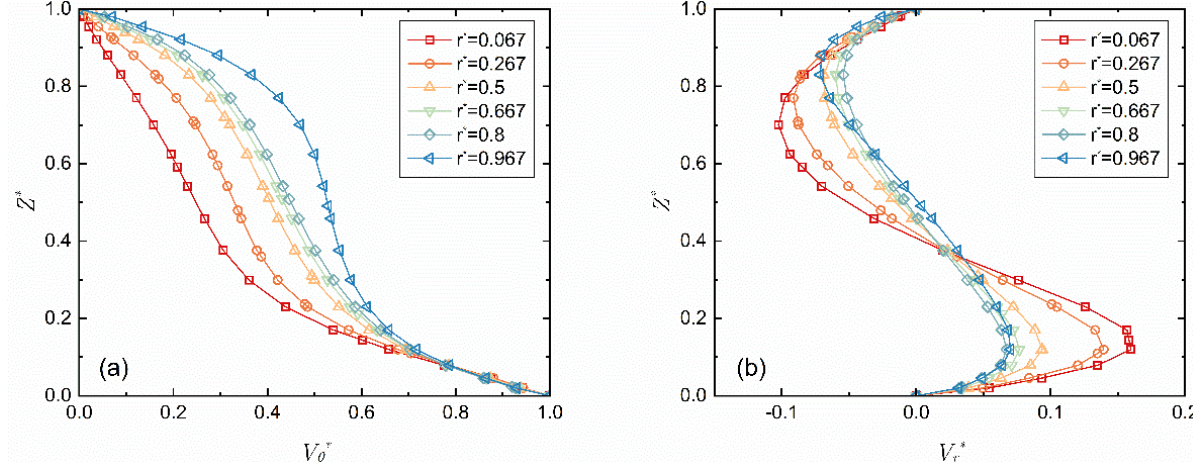
Figure 2. Distribution curve of mean velocity along the z-axis when Re = 7.02 × 10 4 (12,000 rpm) and G = 0.027. ( a ) Circumferential velocity; ( b ) Radial velocity.